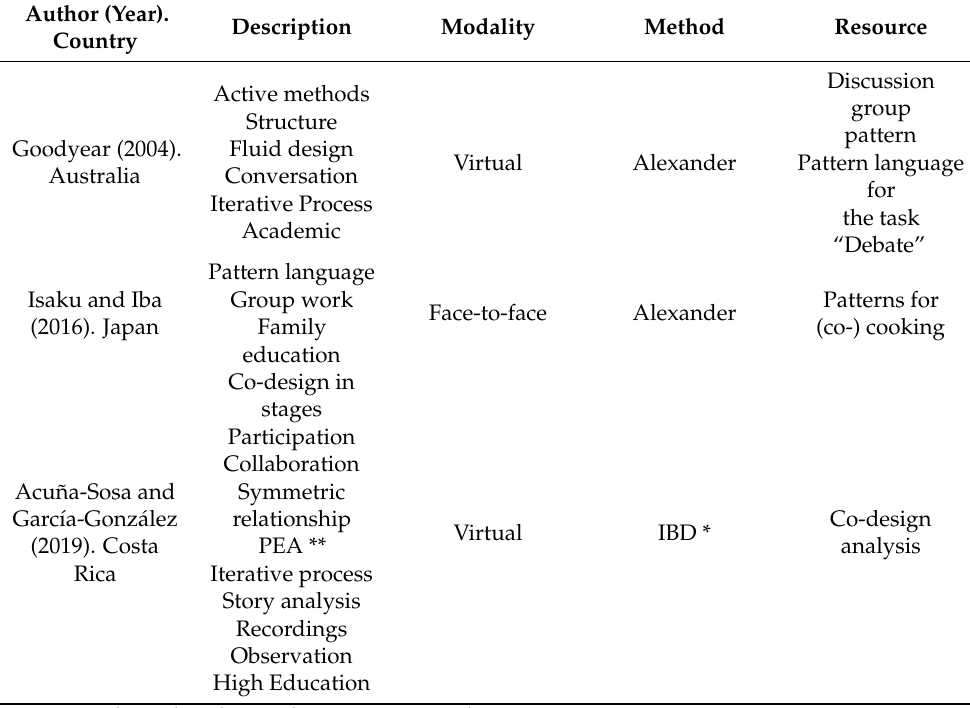
Table 5. Grid of pedagogical patterns in Australia, Japan, and Costa Rica. Author